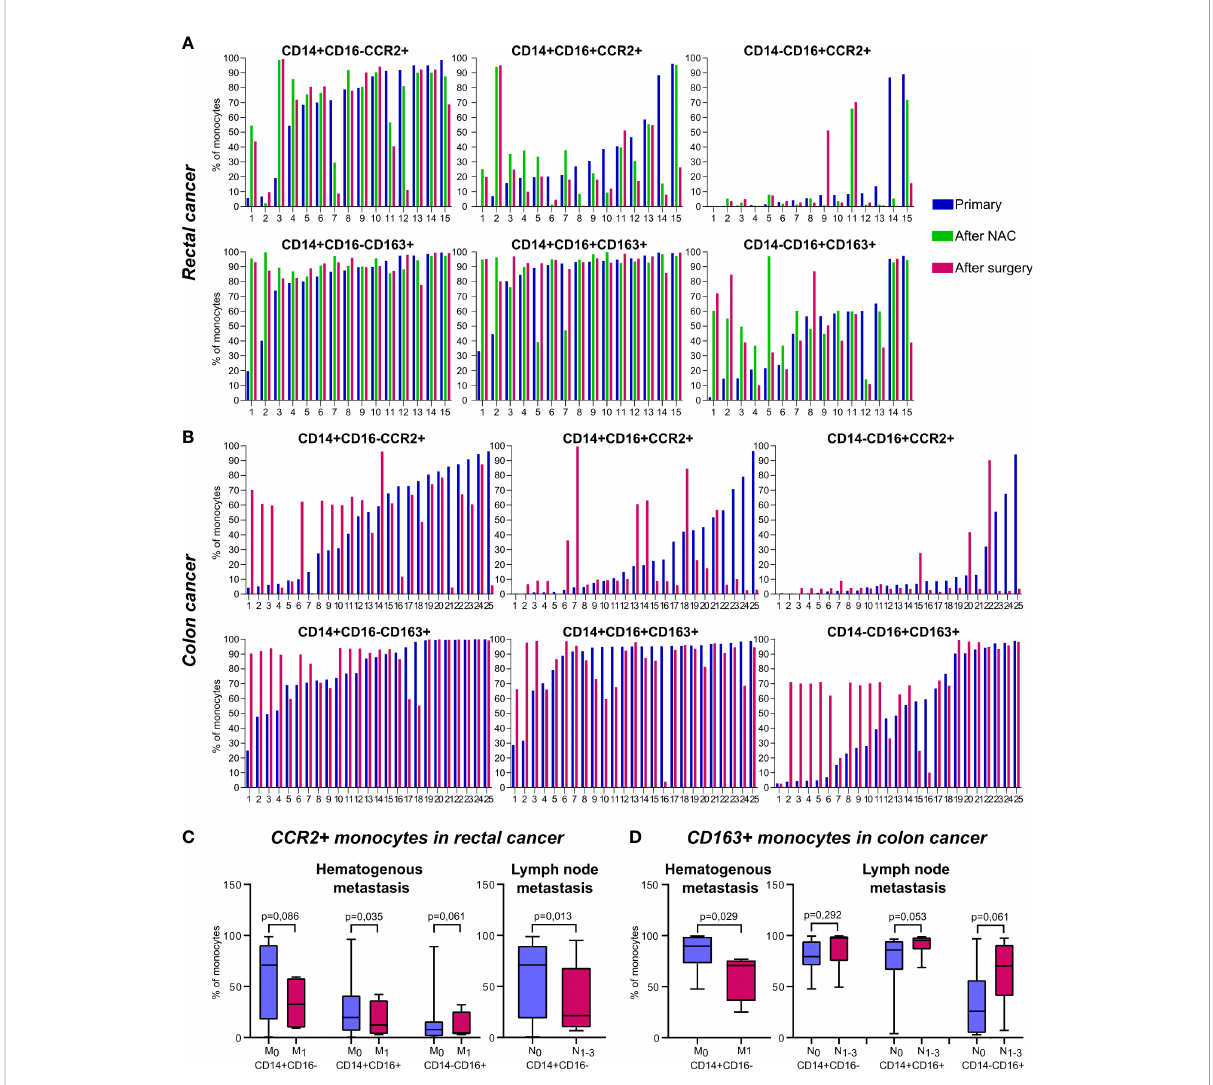
FIGURE 2 The distribution of CD163+ and CCR2+ peripheral blood monocytes in patients with colon and rectal cancers. Individual pro fi les of CCR2+ and CD163+ monocyte subsets for each patient with rectal and colon cancers. (A) , The distribution of monocytes of classical (CD14+CD16-), intermediate (CD14+CD16+) and non-classical (CD14-CD16+) populations expressing CCR2 (upper panel) and CD163 (lower panel) is demonstrated before and after NAC and after surgical resection in rectal cancer patients. (B) , The distribution of monocytes of classical (CD14 +CD16-), intermediate (CD14+CD16+) and non-classical (CD14-CD16+) populations expressing CCR2 (upper panel) and CD163 (lower panel) is demonstrated before and after surgical resection in colon cancer patients. (C) , Associations of CCR2-expressing monocyte subsets with hematogenous and lymphatic metastasis in rectal cancer patients. (D) , Associations of CD163-expressing monocyte subsets with hematogenous and lymphatic metastasis in colon cancer patients. M 0 , metastasis-negative status, M 1 , metastasis-positive status. N 0 , lymph node-negative status, N 1-3 , lymph node-positive